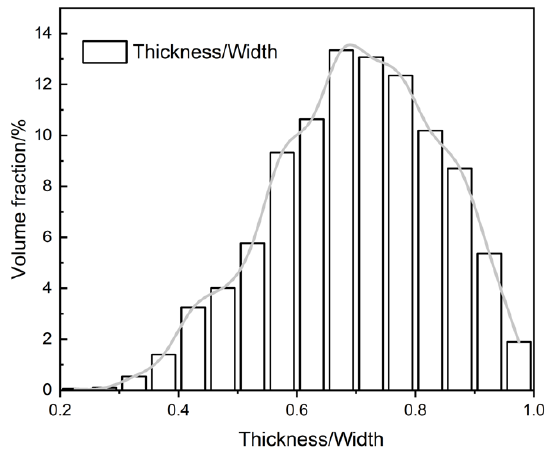
Figure 11. Volume-based distribution histogram for the flatness index, FI .